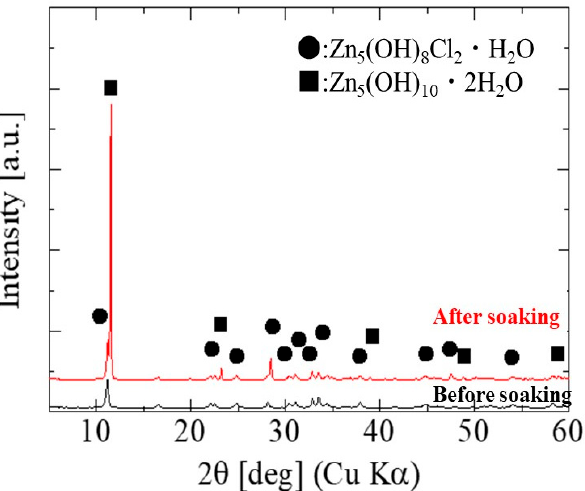
Figure 5. The X-ray diffraction patterns of simonkolleite before and after soaking in physiological saline for 7 days.